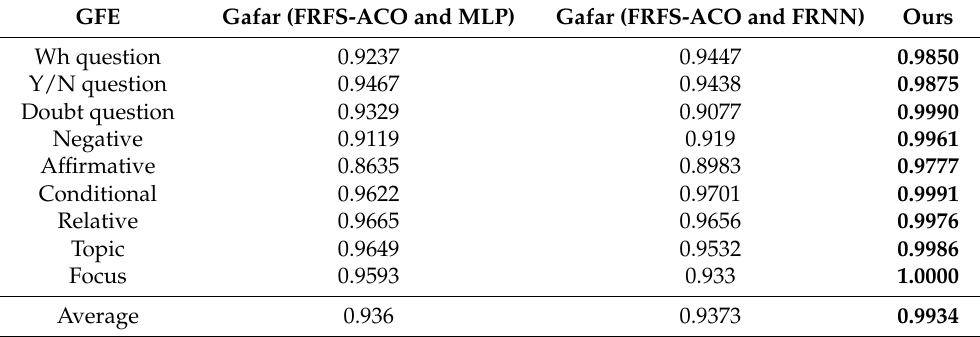
Table 2. Accuracy achieved by our proposed model and other state-of-art approaches using a dataset storing grammatical facial expressions of the Brazilian sign language (Libras) made by subject one. Best results are in bold.